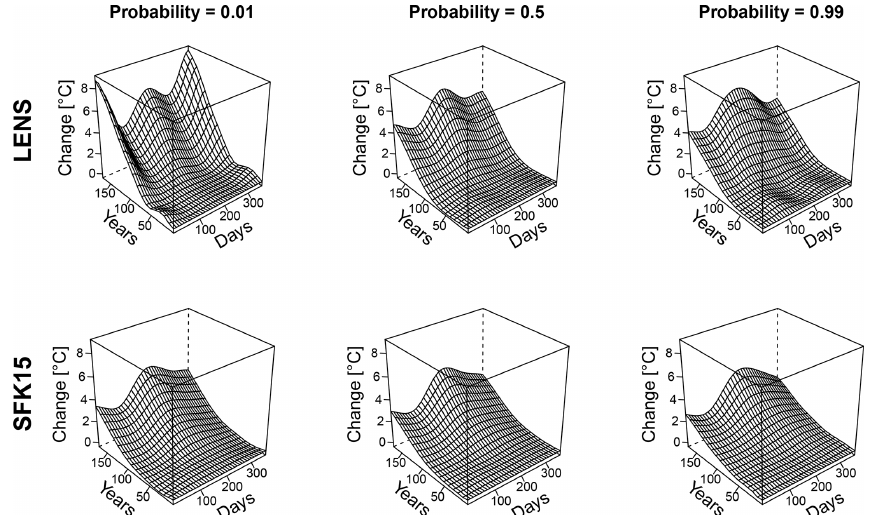
Figure A1. LENS and SFK15 quantile maps at a grid cell containing Seattle as a function of years elapsed since 1920 and day of the year. At year zero, the quantile maps both produce zero change since the initial and final time are the same. Each column of plots shows the changes in quantiles as a function of the non-exceedance probability given for that column.